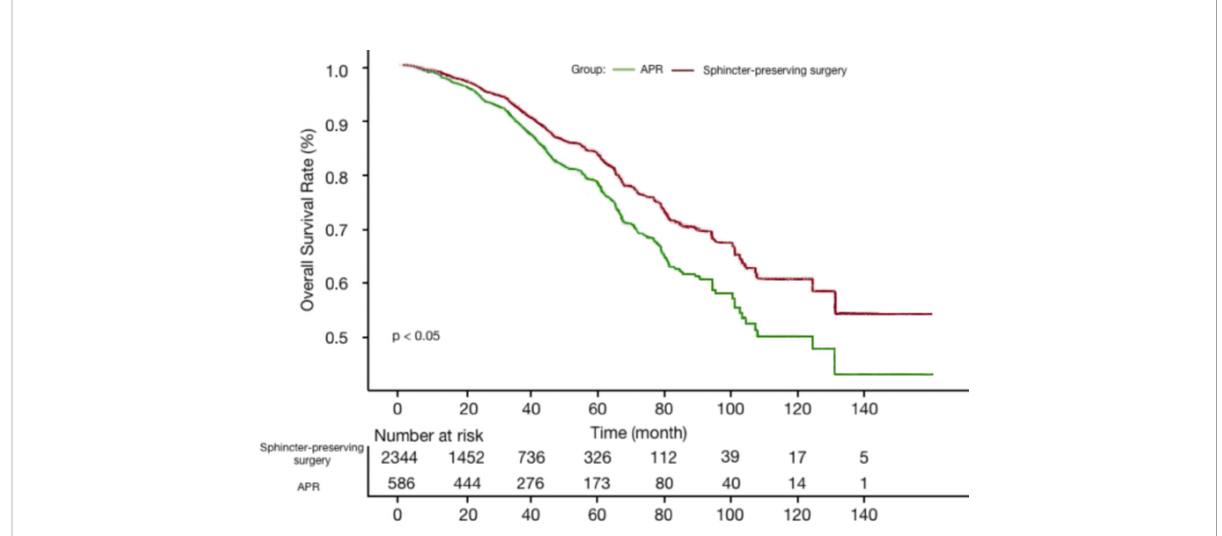
FIGURE 2 Kaplan-Meier curve for patients with sphincter-preserving surgery compared with APR. APR, Abdominoperineal